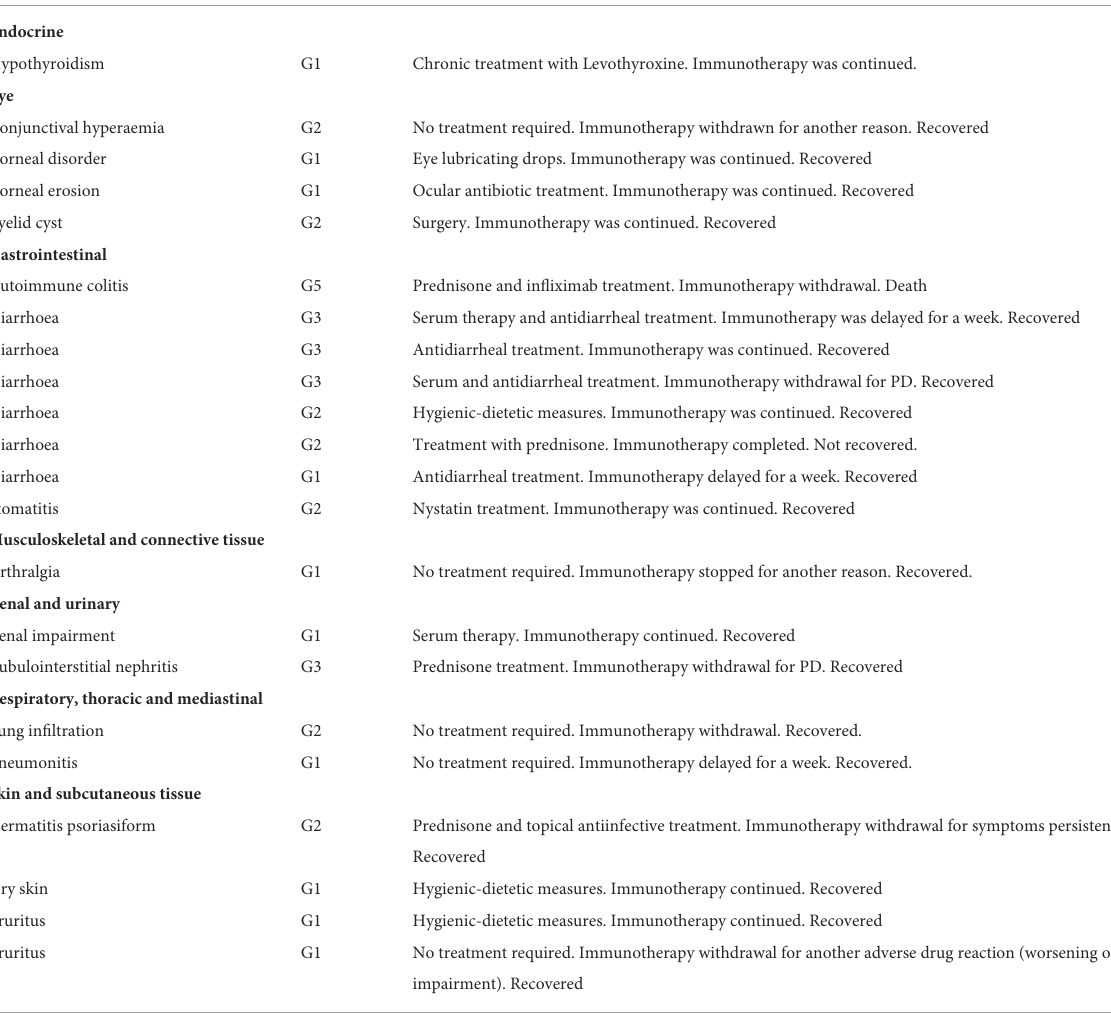
TABLE 3 Characteristics of late immune-related